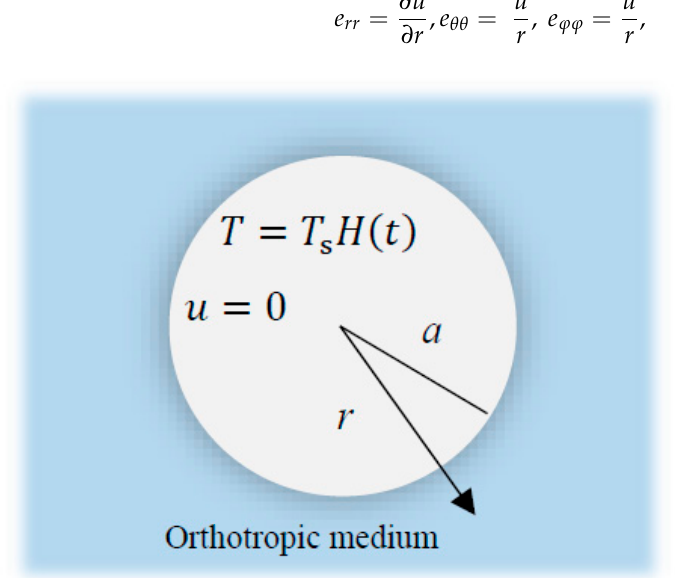
Figure 1. The diagram of an unbounded medium with a spherical